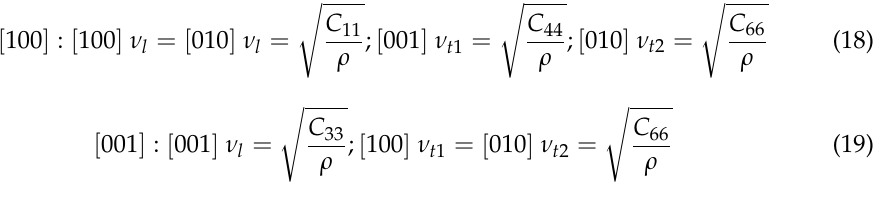
Table 4. The density ρ , transverse sound velocity v t , longitudinal sound velocity v l , mean sound velocity v m and Debye temperature Θ D of pure and doped Al 3 Li phase.